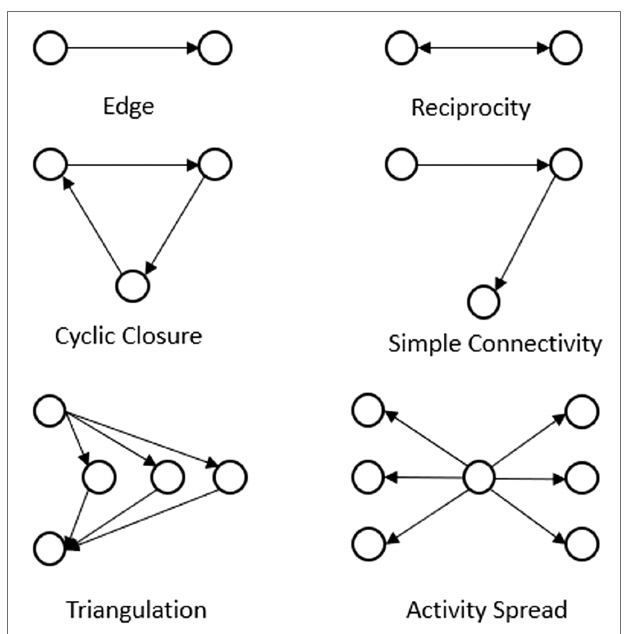
FIGURE 3 | Selected subgraphs in social networks included in the